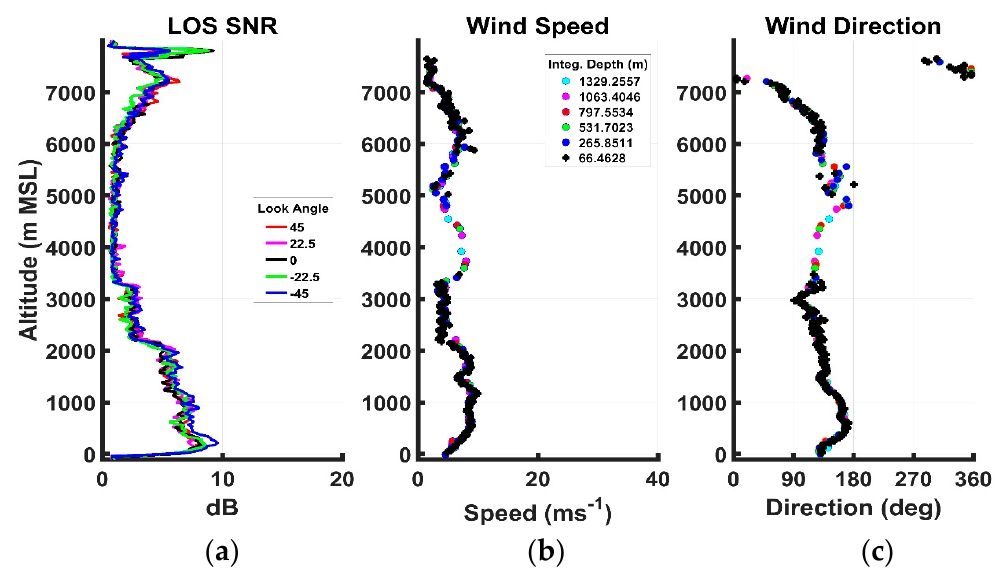
Figure 16. DAWN vertical profiles of SNR ( a ), wind speed ( b ) and wind direction ( c ) for the mid point of the western S-N leg of 27 May 2017 Box A at 202220Z.